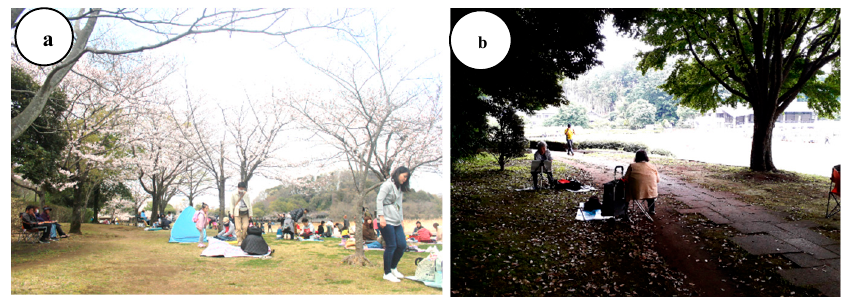
Figure 2. Seated-viewing experiment site in Forest and Park for the 21st Century: ( a ) cherry-blossom-viewing in spring; ( b ) leisure activities in summer.